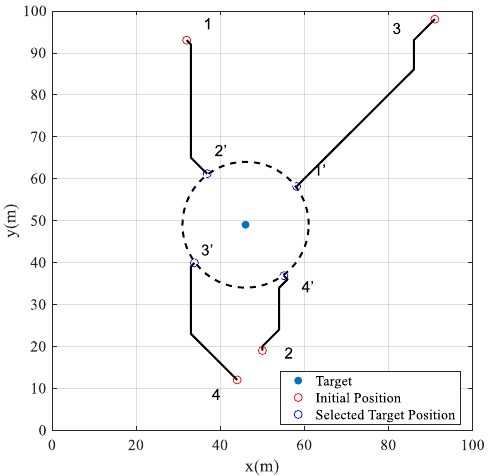
Figure 8. Position adjustment with the Hungarian algorithm.